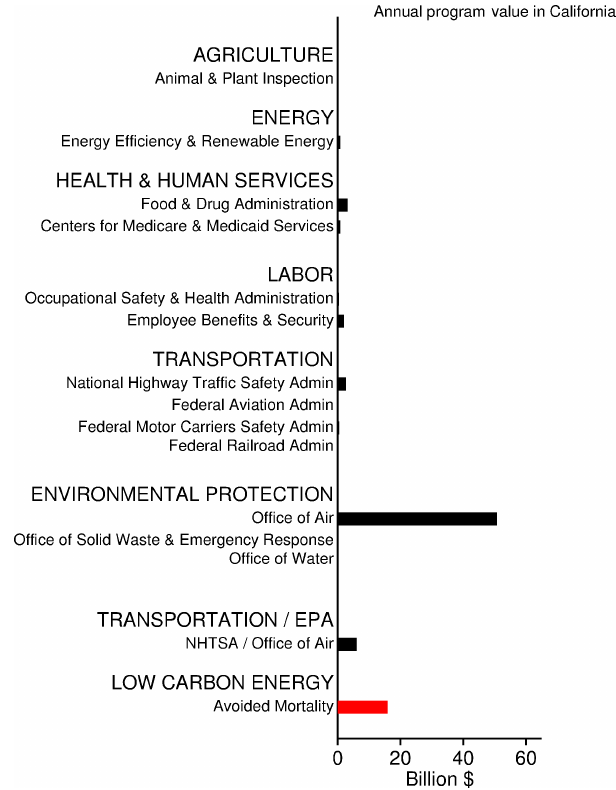
Figure 8. Annual “fair-share” benefits of federal programs that af- fect California in 2016. The fair-share fraction of US total is pro- portional to the fraction of US population living in California. “Low Carbon Energy” represents the difference between the 2050 GHG- Step–BAU scenarios calculated in the present